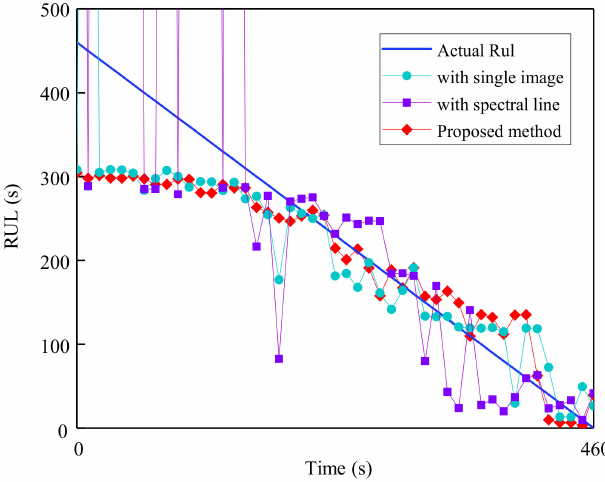
Figure 6. RUL prediction results of bearing 4.